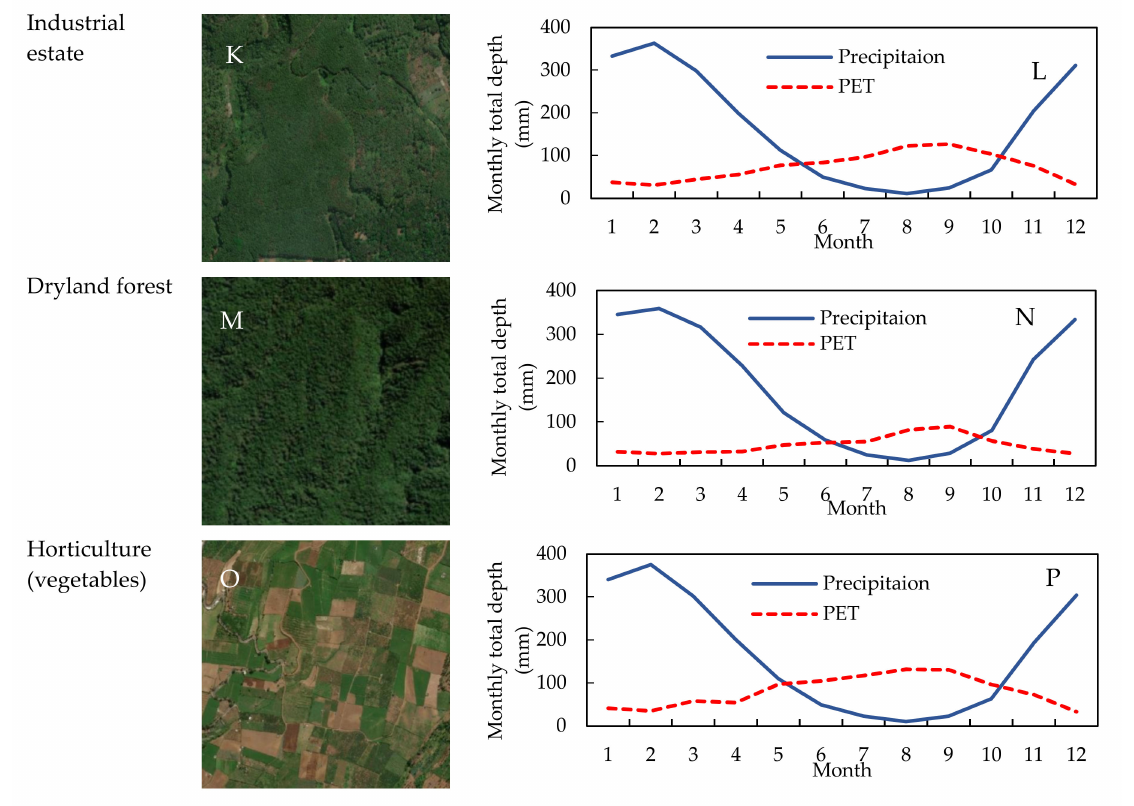
Figure 10. Ground cover and Monthly pattern of water balance under different vegetated land uses in Brantas: teak ( A , B ); sugarcane plantation ( C , D ); rice-field ( E , F ); dryland farming ( G , H ); savana ( I , J ); industrial estate ( K , L ); dryland forest ( M , N ); horticulture (vegetables) ( O , P